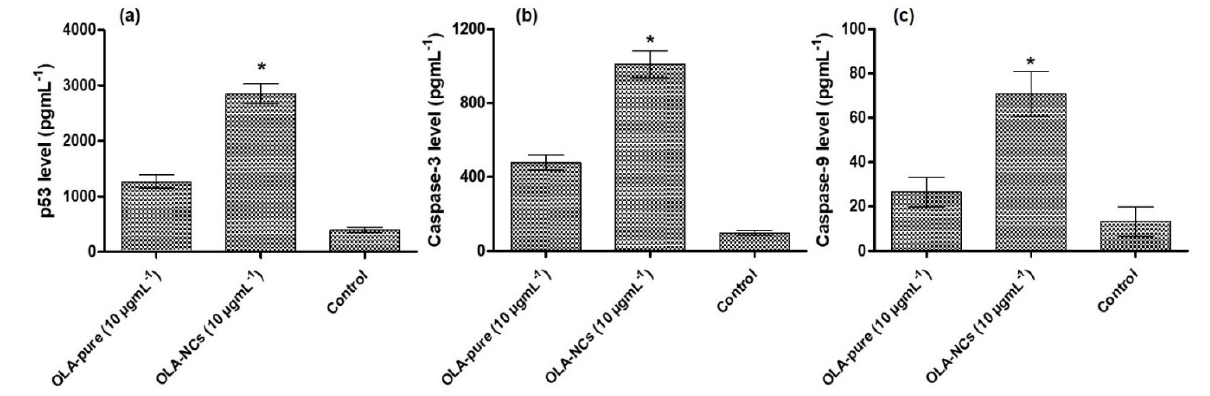
Figure 9. Effects of OLA-pure and OLA-NCs on the activation of p53 level ( a ); Caspase-3 level ( b ) and Caspase-9 level ( c ) in MCF-7 treated cells. The data were represented as mean of three readings with standard deviations (Mean ± SD, n = 3). * p < 0.05 indicated the significant difference between the activities of OLA-NCs vs. OLA-pure as compared to the untreated (control) cells.